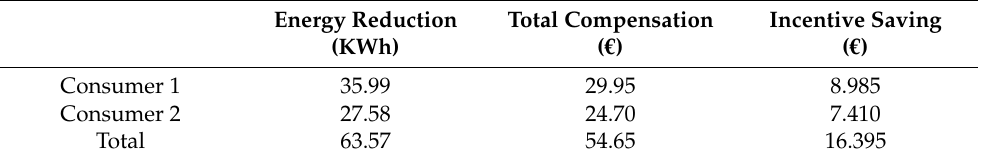
Table 11. Total energy reduction and total compensation for each